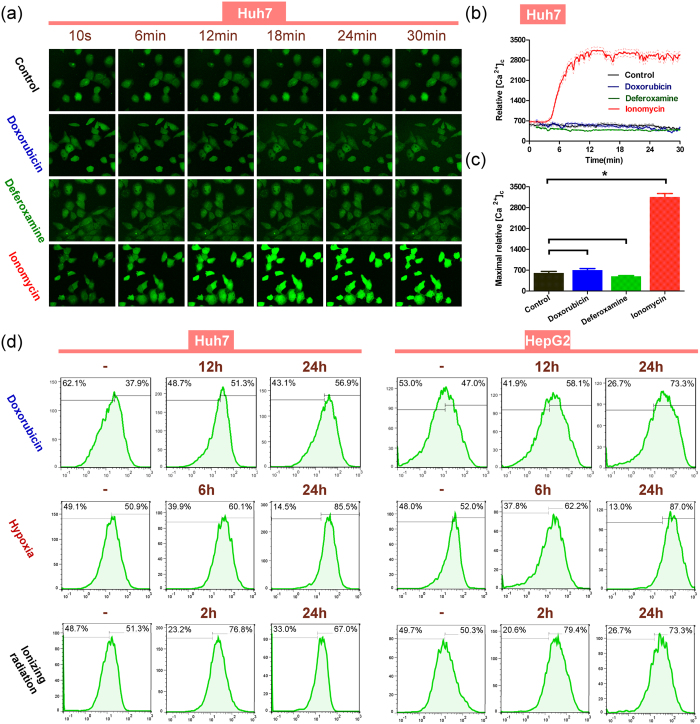
Various stimuli produce a significantly long-term and sustained, but not immediate, increase in cytosolic calcium.(a) Dynamic monitoring of [Ca2+]c immunofluorescence within 30 min after adding doxorubicin (0.2 μg/mL), deferoxamine (100 μM), ionomycin (2 μg/mL) or HBSS (control group) to Huh7 cells incubated with Fluo4-AM calcium indicator. Ionomycin, known as an ionophore Ca2+, was used as a positive control to increase [Ca2+]c markedly. (b) Changes in mean cytosolic calcium fluorescence values of Huh7 cells (n = 11–18) treated by doxorubicin (0.2 μg/mL) (blue), deferoxamine (100 μM) (green) and ionomycin (2 μg/mL) (red) are shown, with the mean lines (solid) and 95% CI lines (dashed). Reagents were added at the 3 min. time point. (c) The maximum calcium fluorescence values (mean ± SD) were calculated after adding doxorubicin (blue), deferoxamine (green) and ionomycin (red) within 30 min, respectively. (*p < 0.05, each treatment group vs. control group). (d) Cells were treated by doxorubicin (0.2 μg/mL), hypoxia (1% O2) and ionizing radiation (10Gy) and the cytosolic calcium immunofluorescence was measured by flow cytometry. Vertical split lines were set at the same fluorescence intensity level and right proportion of cell numbers was calculated. Statistical significances were assessed using Student’s T-Test.